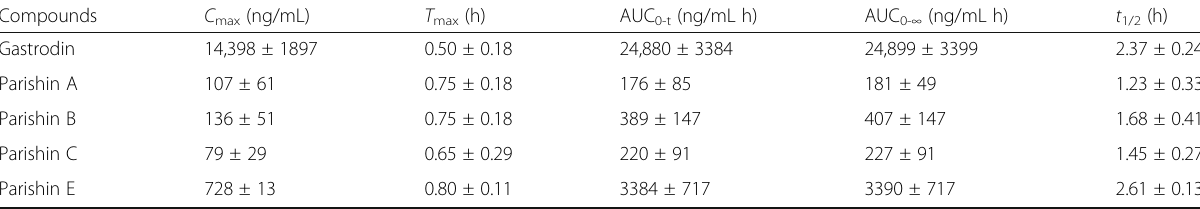
Table 5 Pharmacokinetic parameters for gastrodin, parishin A, parishin B, parishin C, and parishin E in rats after the oral administration of the extracts of G. elata at 10 g/kg Compounds C max (ng/mL) T max (h) AUC 0-t (ng/mL h) AUC 0- ∞ (ng/mL h) t 1/2 (h) Gastrodin 14,398 ± 1897 0.50 ± 0.18 24,880 ± 3384 24,899 ± 3399 2.37 ± 0.24 Parishin A 107 ± 61 0.75 ± 0.18 176 ± 85 181 ± 49 1.23 ± 0.33 Parishin B 136 ± 51 0.75 ± 0.18 389 ± 147 407 ± 147 1.68 ± 0.41 79 ± 29 0.65 ± 0.29 220 ± 91 227 ± 91 1.45 ± 0.27 Parishin E 728 ± 13 0.80 ± 0.11 3384 ± 717